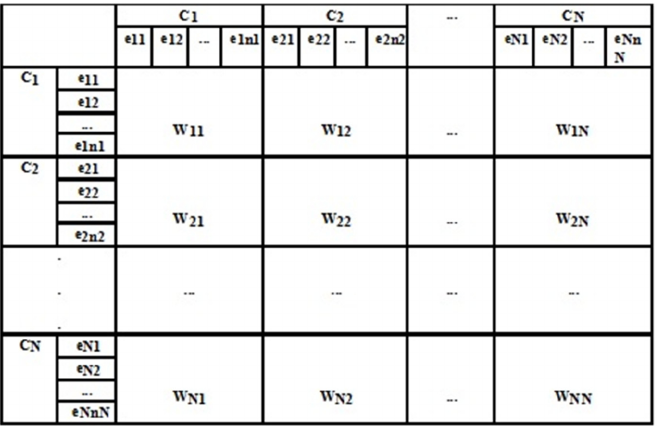
Figure 3. General structure of the super matrix.